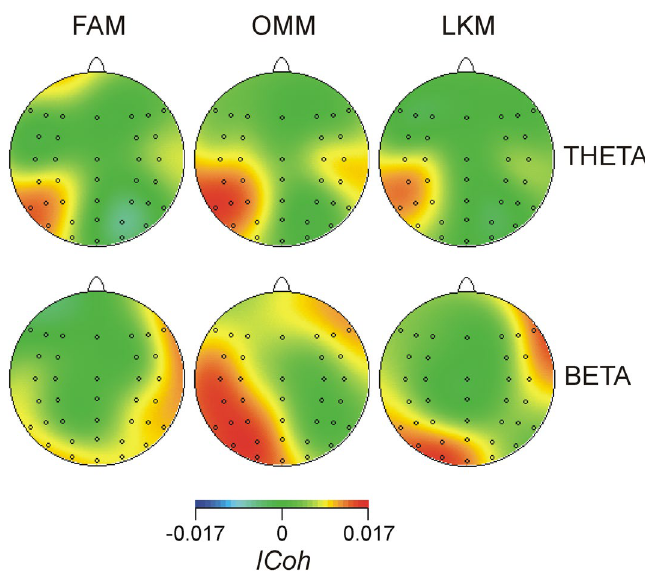
Figure 4. Connectivity of the medial frontal network during meditation. Topography maps of grand average ICoh difference are presented (FAM, OMM and LKM minus REST). Upper row presents theta frequency range (4–7 Hz), and lower row—beta frequency range (15–20 Hz). Red colour indicates meditation-related